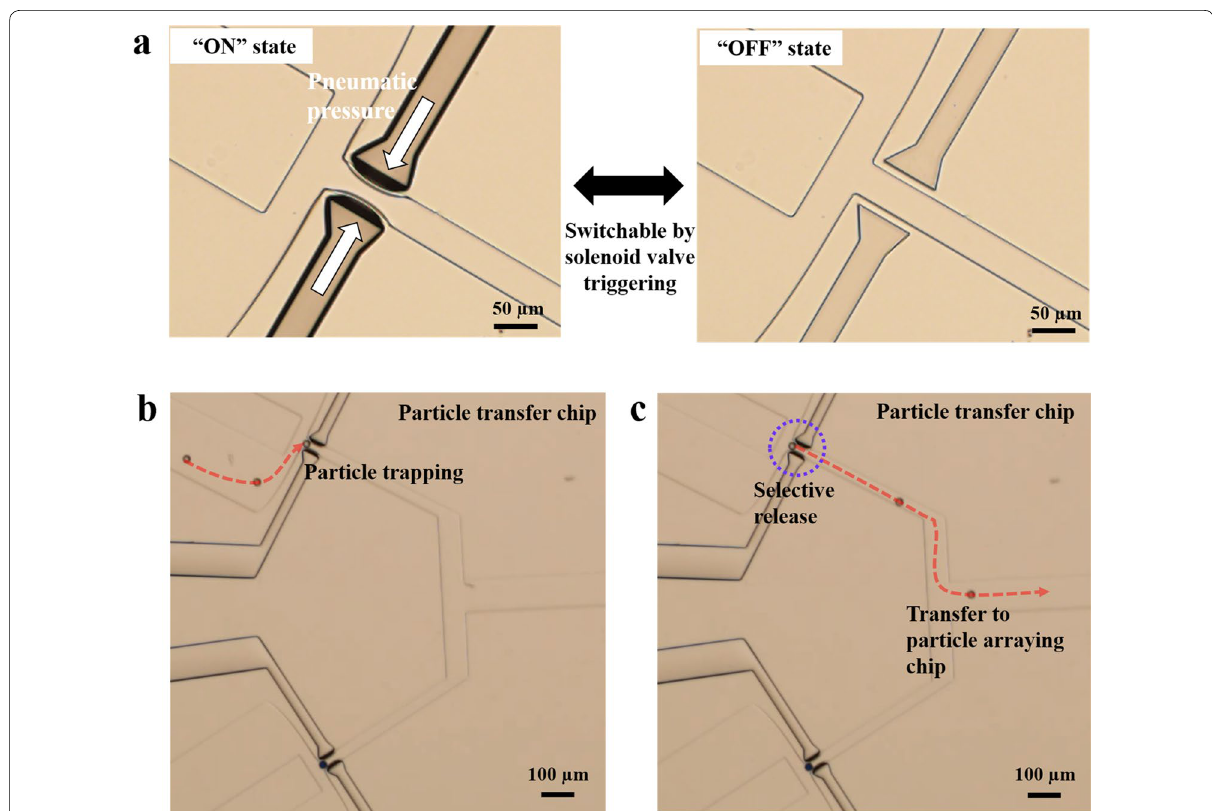
Fig. 2 On-demand particle transfer utilizing pneumatic valve operation. a Depending on the applied pneumatic pressure, the valve wall is either deflected (“ON” state) or not (“OFF” state). These two states are switchable by controlling the integrated solenoid valve. b Particle trapping. Single particle is trapped at the narrow channel created by valve deflection. c Particle releasing. Removing the pneumatic pressure allows the trapped particle to be released and transferred in an on-demand